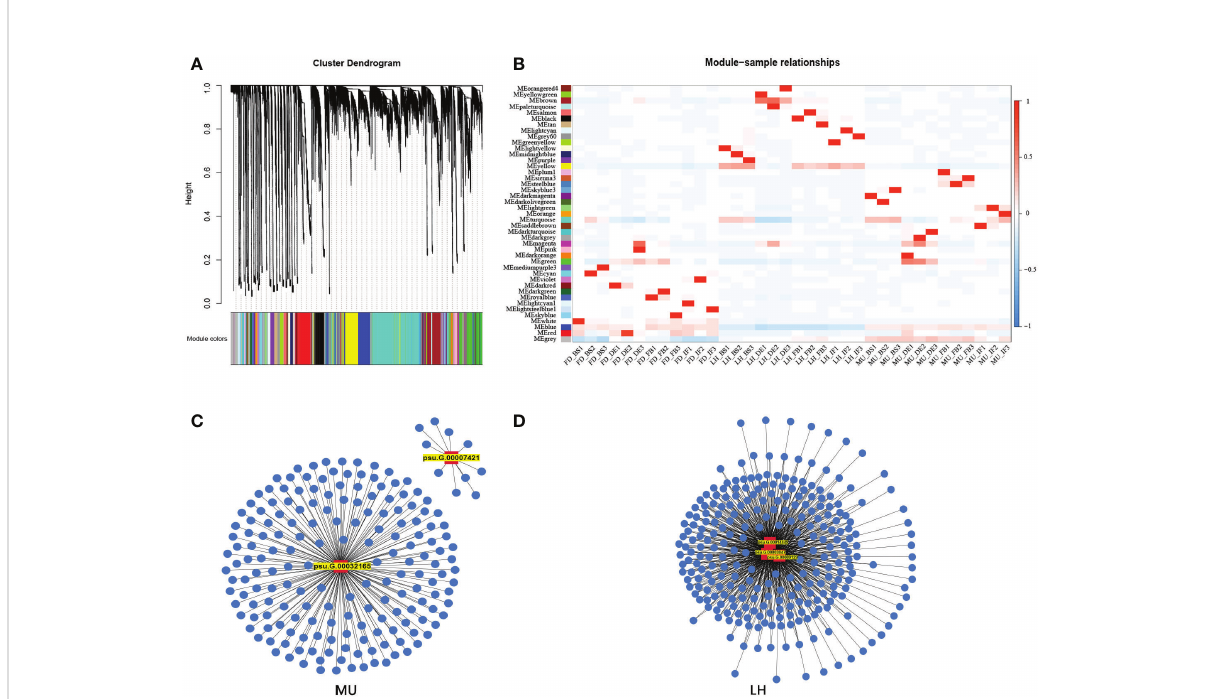
FIGURE 9 WGCNA analysis of differentially expressed genes regulating fl oral fl orescence, development and senescence. (A) Hierarchical cluster tree showing co-expression modules. (B) Module-samples relationships. (C) Hub gene regulating fl oral fl orescence, development and senescence in LH. (D) Hub gene regulating fl oral fl orescence, development and senescence in MU.